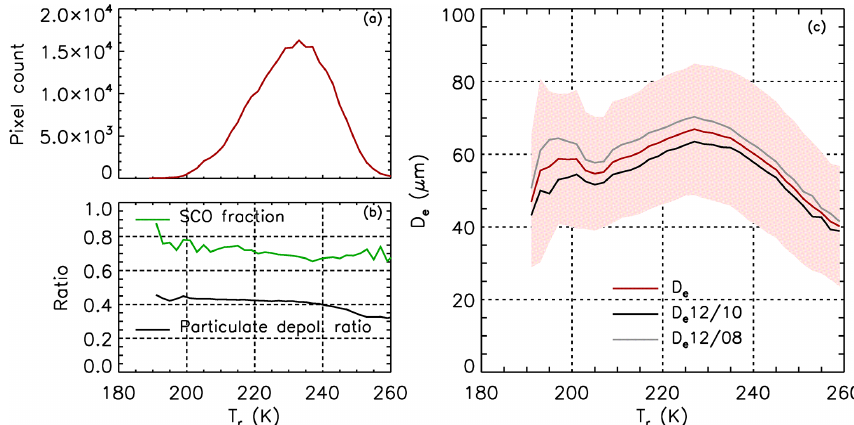
Figure 10. Same as Fig. 9 but for opaque